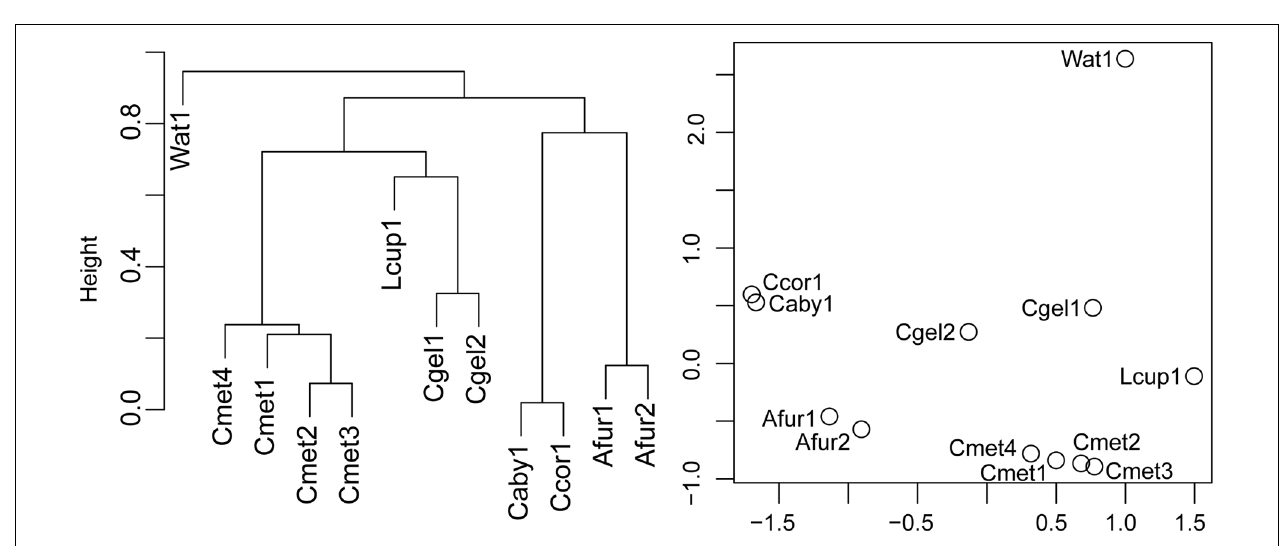
FIGURE 7 | Heatmap of relative abundance (%) of the most common prokaryote groups in the dataset at genus level.